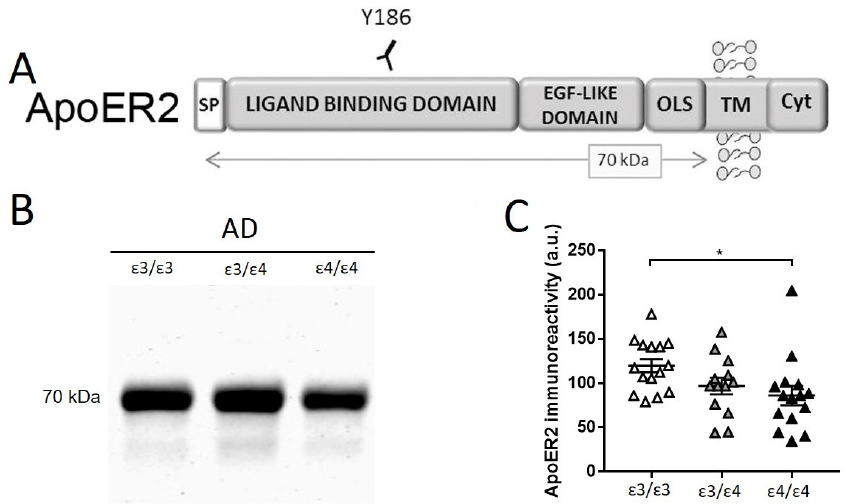
Figure 4. Characterization of apoER2 in CSF samples from AD. ( A ) Schematic representation of the apoER2 receptor and the epitope recognized by the Y186 antibody used in the study. ApoER2 is composed of a signal peptide (SP), followed by a ligand-binding domain containing an EGF-like region, an O-linked sugar domain (OLS), a transmembrane (TM) segment, and a cytoplasmic domain (Cyt). ApoER2 is processed by α -secretase upon ligand binding, generating a soluble ectodomain fragment (~70 kDa). ( B ) Representative blot of human CSF samples from AD subjects subgrouped by APOE genotype (15 APOE ε 3/ ε 3, 13 APOE ε 3/ ε 4, and 15 APOE ε 4/ ε 4 subjects) and resolved with the indicated Y186 antibody. ( C ) Densitometric quantification and statistical analysis of the immunoreactivity and the 70 kDa ecto-apoER2 fragment. Samples are separated by APOE genotype: APOE ε 3/3 (white), APOE ε 3/ ε 4 (grey), and APOE ε 4/ ε 4 (black). * p <